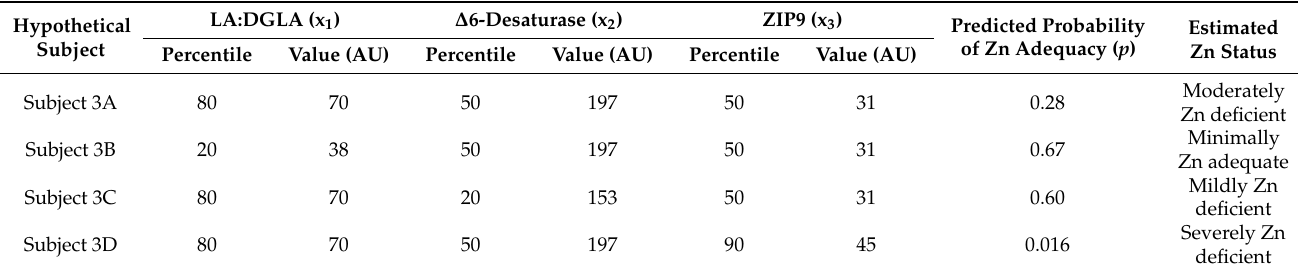
Table 8. Predicted probability of Zn adequacy of hypothetical animal subjects using the above ZSI example 3 1